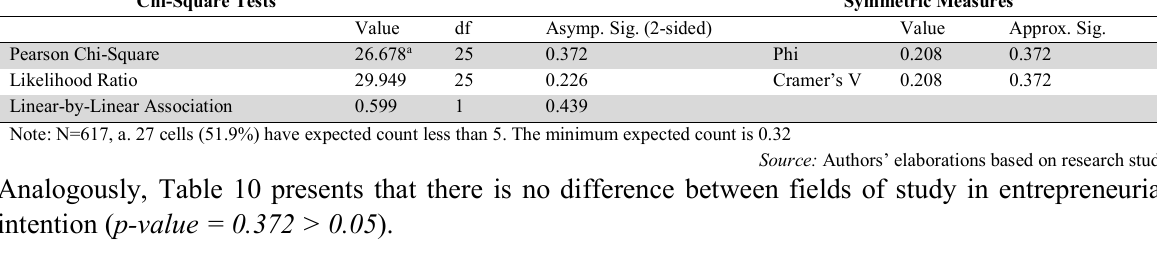
Chi-Square and Cramer’s V results for field of study difference in entrepreneurial intention Chi-Square